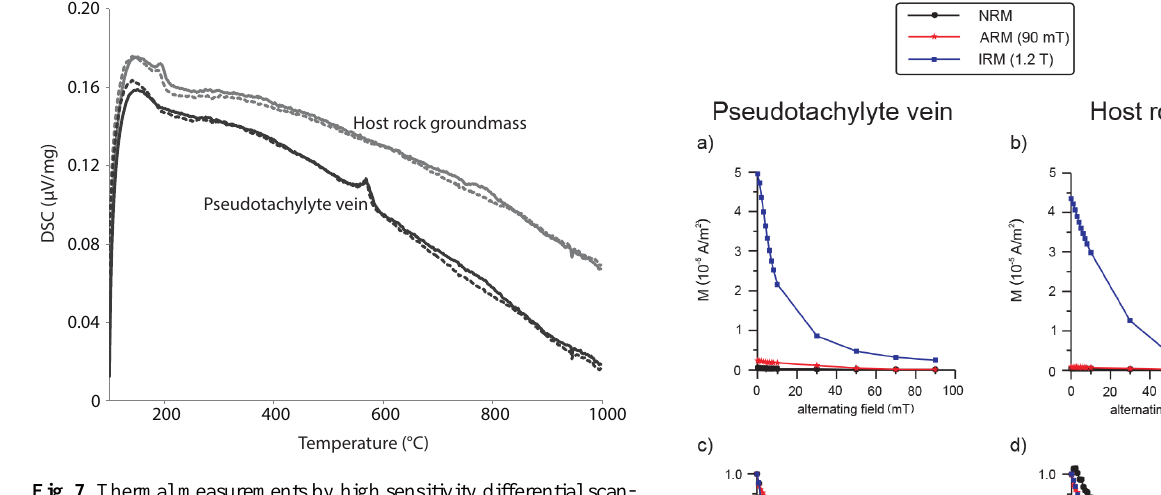
Fig. 7. Thermal measurements by high sensitivity differential scan- ning calorimetry (HS-DSC). Measurements were carried out using a Netzsch DSC 404 C. A sharp endothermic peak at about 190 ◦ C in the host rock (light grey trace) corresponds to a cristobalite α – β phase transition and the trace shows no evidence of a potential glassy phase. An endothermic peak at about 570 ◦ C corresponding to the α – β phase transition in quartz is seen in the pseudotachylyte vein (dark grey trace). The same exothermic peaks are visible on the second run of the experiments with the same sample (dashed lines), confirming their respective phase transitions.